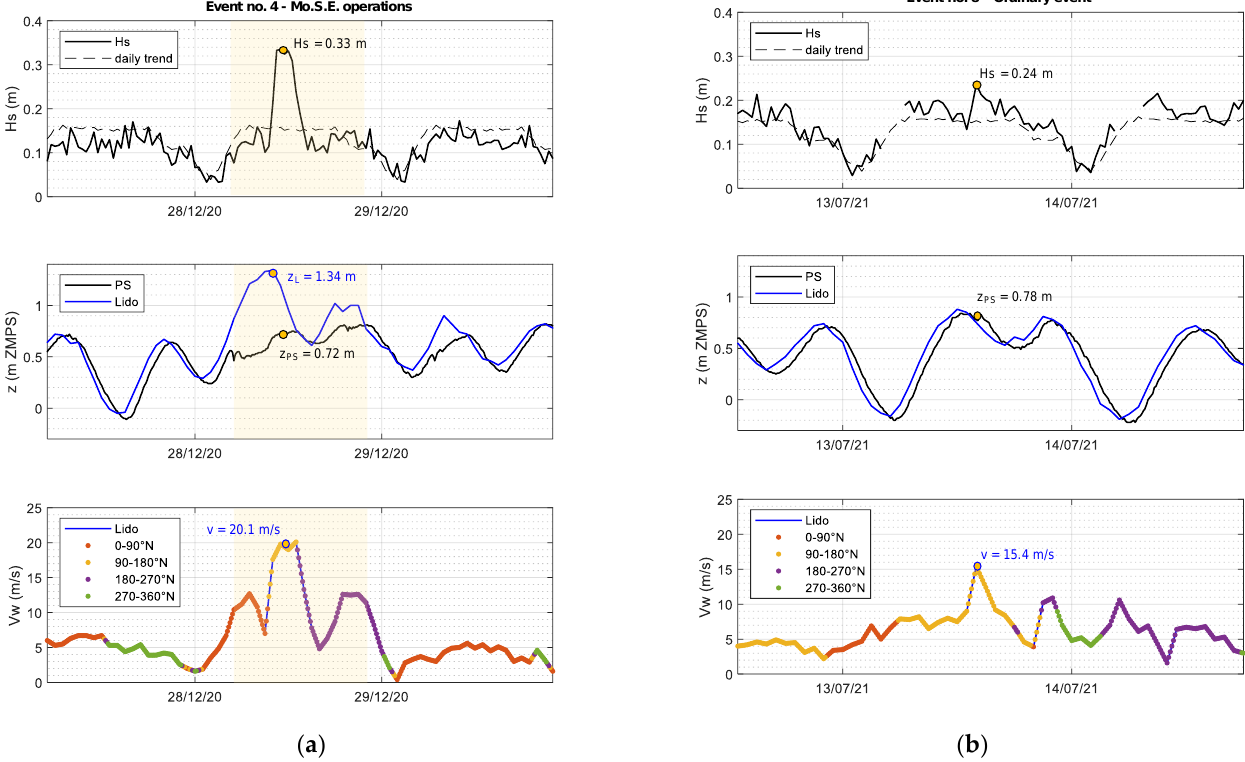
Figure 5. Time series of H S , sea levels ( z ) at the Punta della Salute gauge and at the Lido inlet and wind intensity ( V w ) with information also on wind direction ( D w ). ( a ) during a Mo.S.E. closure, 28 December 2020; the yellow light box indicates the Mo.S.E. closure and ( b ) an ordinary event, 13 July 2021.